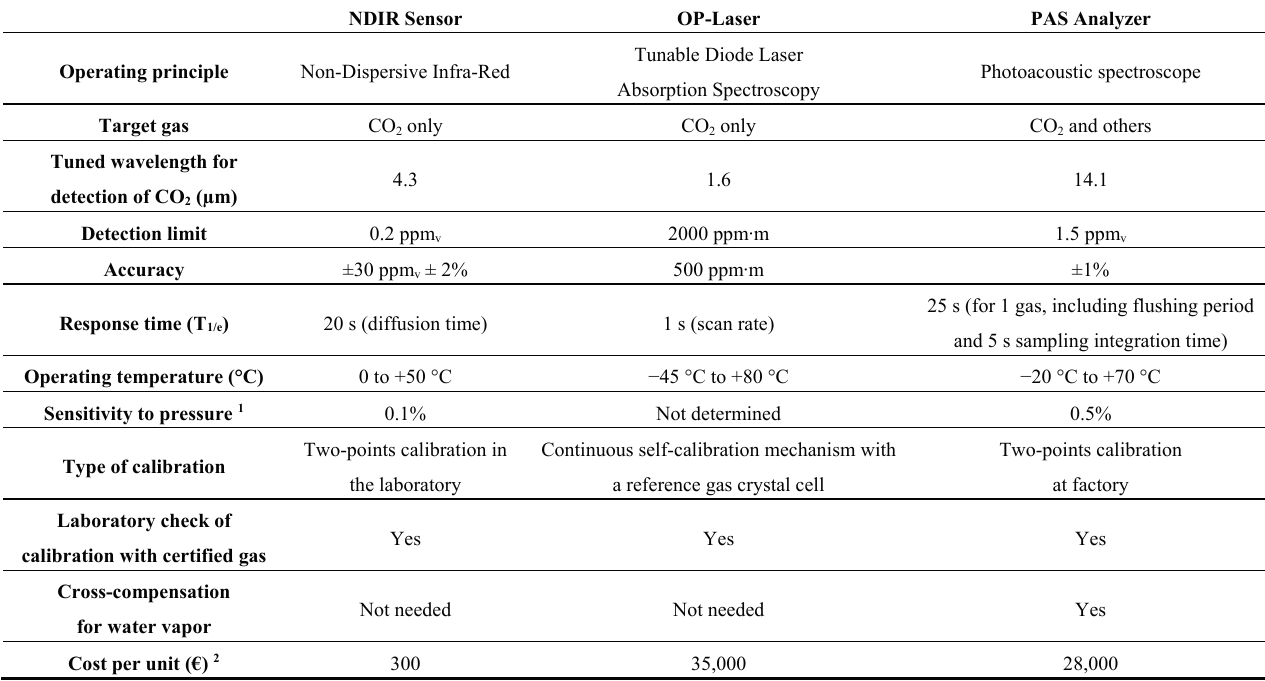
Table 1. Technical specifications of the CO 2 measuring devices used in this